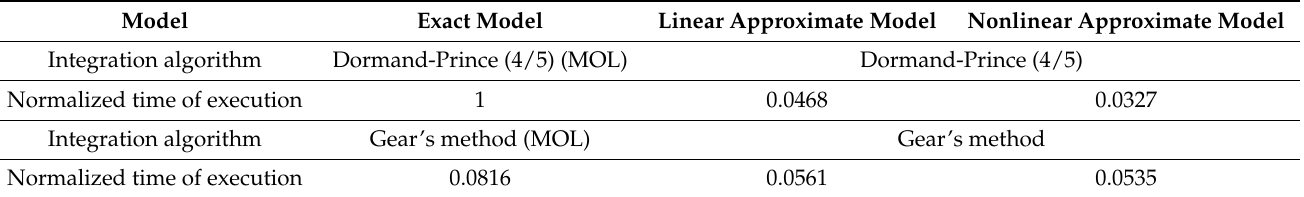
Table 3. Execution times of computer programs solving the exact model and the approximate models.